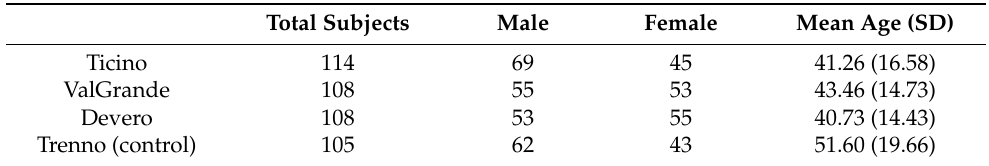
Table 2. Descriptive statistics of the study sample.